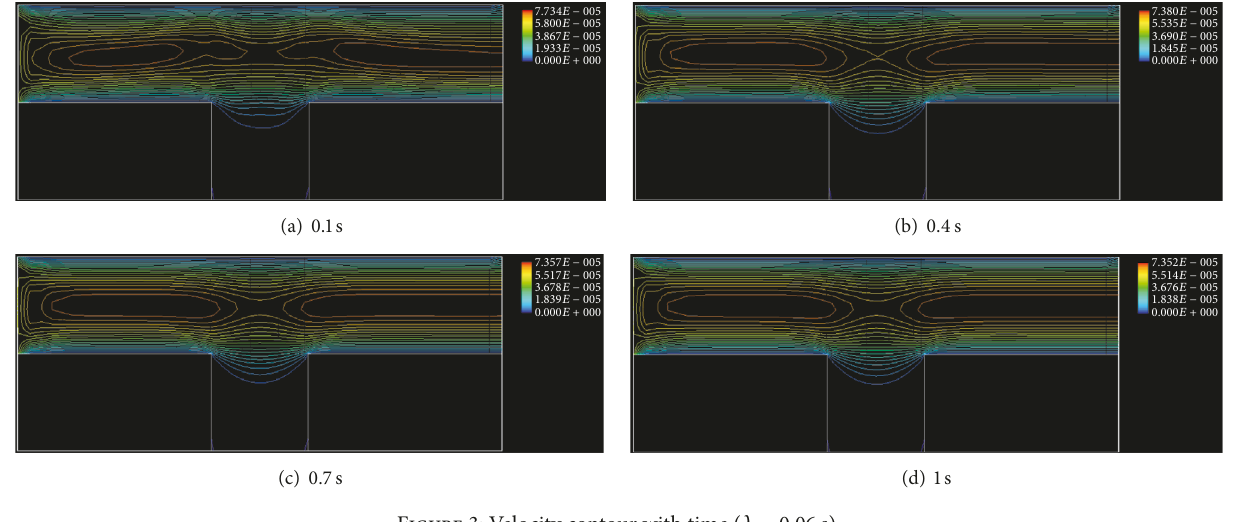
Figure 3: Velocity contour with time ( 𝜆 = 0.06